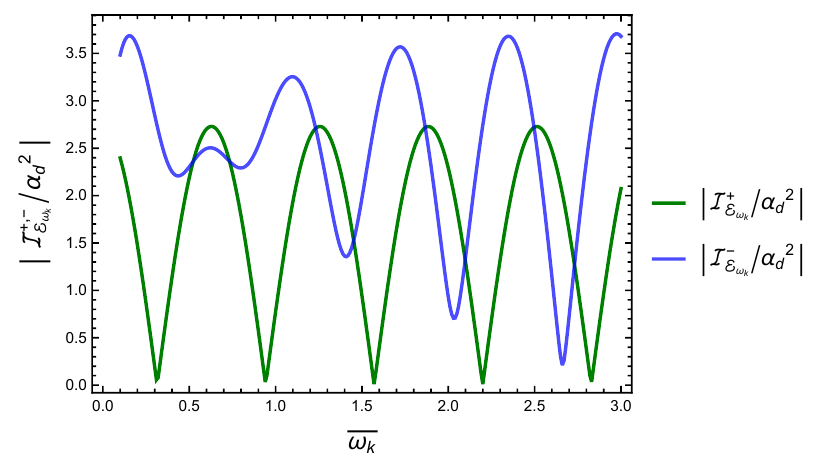
and |I − are plotted in green and blue lines, respectively Figure 29 . The quantities |I + | /r 2 | /r 2 H H E ωk E ωk for two outgoing null detectors in different parallel paths in a (1+1) dimensional de Sitter spacetime with respect to the separation between the two paths d/r . The dimensionless frequency of the H field are fixed at d/α = 5 .The detector transition energy is fixed at ∆ E = 0 . 5 . d